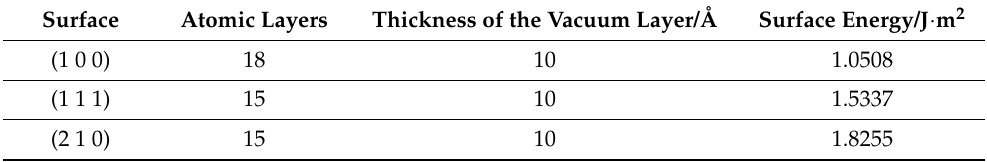
Table 3. Surface energy of different surfaces of pyrite.